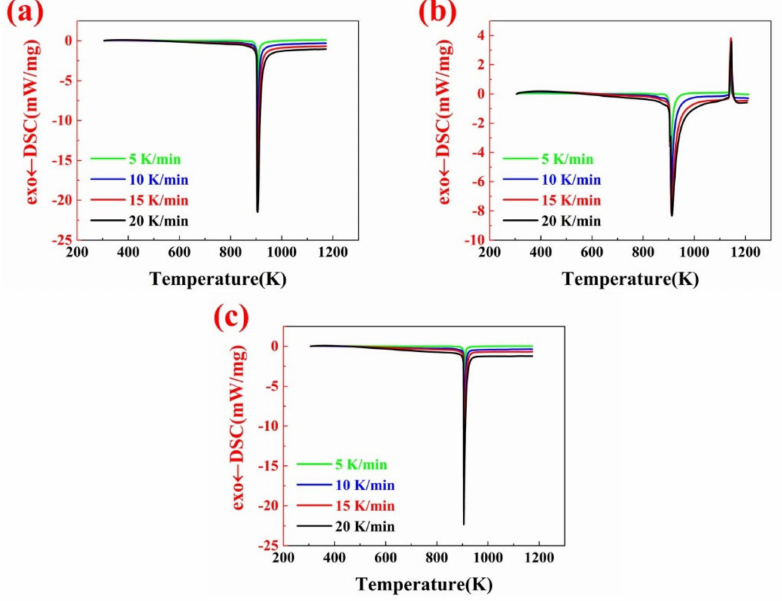
Figure 2. DSC curves of Ni/Al energetic structural materials: ( a ) Ni/Al = 1:1, ( b ) Ni/Al = 1:3, and ( c ) Ni/Al = 3:1.